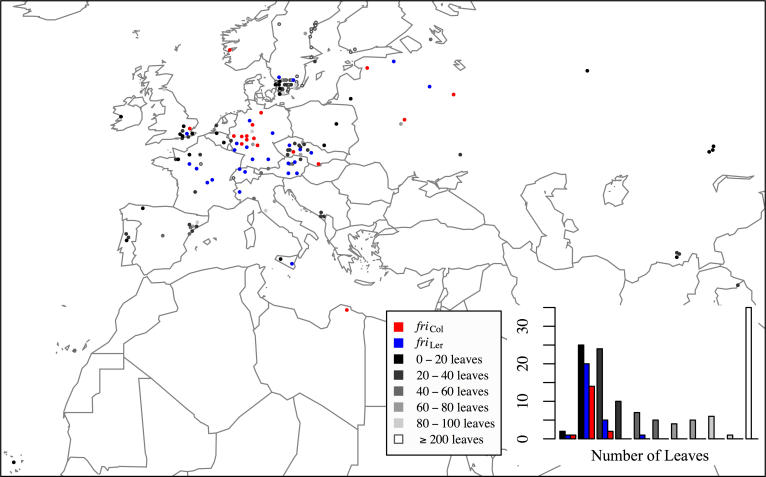
The Effect of Geography and
FRI Alleles on Flowering Time
The map displays the position of 168 accessions from Europe, northern Africa, and western Asia. The histogram inset shows the distribution of the number of leaves at flowering without vernalization for these accessions. In both map and histogram, accessions carrying the
fri
Col or
fri
Ler alleles are indicated in red or blue, respectively, while the shade of gray in the remaining accessions corresponds to the number of leaves (i.e., 0–20). Bin sizes are halved (i.e., 0–10 leaves) in the histogram relative to the map.